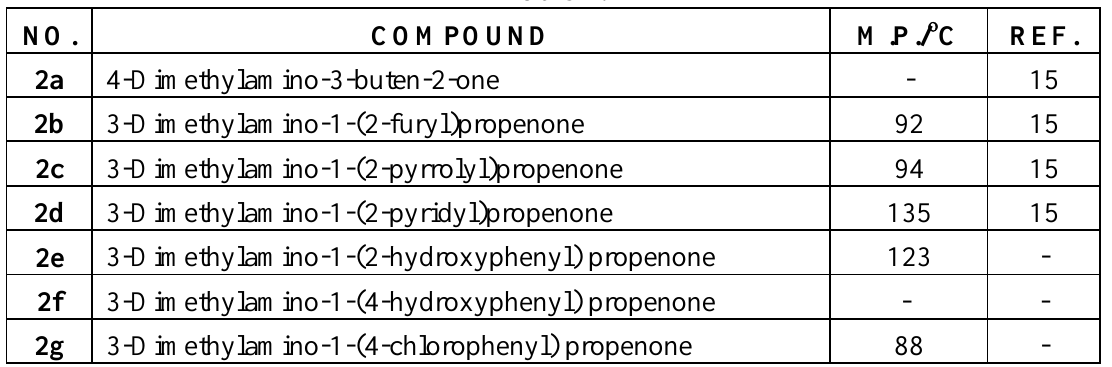
REF. M.P./ ο C COMPOUND